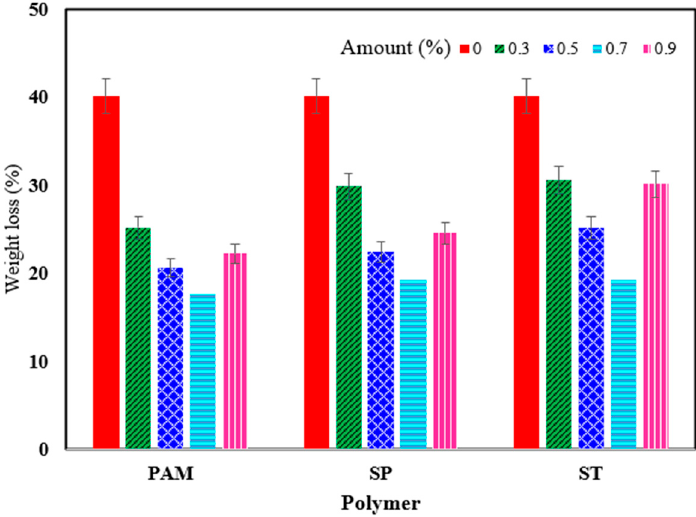
Figure 12. Weight loss of GGBFS geopolymers under sulfate acid attacks at 28 days.